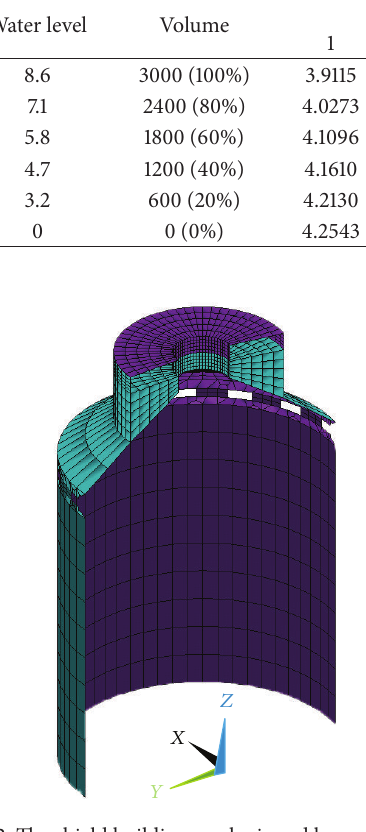
PCCWST are modeled by shell element Shell63 rather than solid element. The mesh of shield building is illustrated in Figure 2 with a partial section